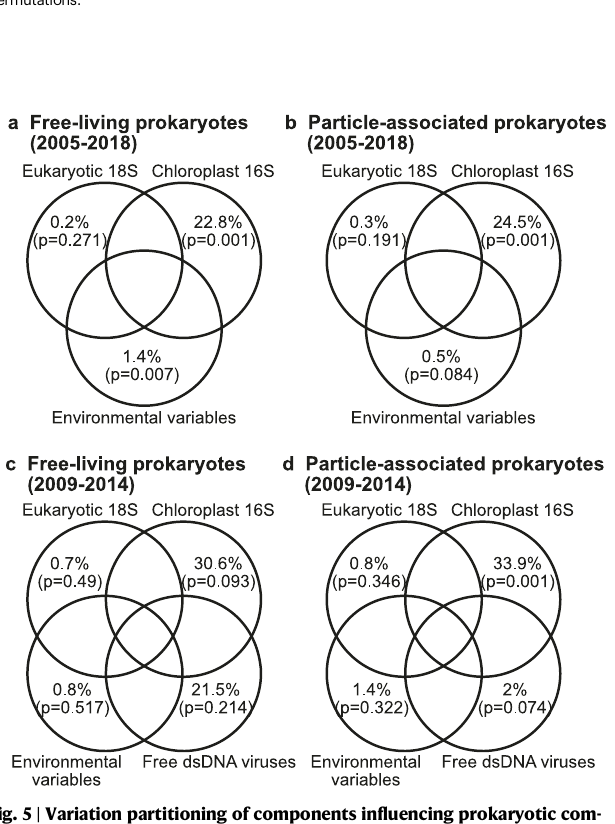
Fig. 5 | Variation partitioning of components in fl uencing prokaryotic com- munity composition. Percentages indicate the portion of the variance in free- living ( a , c ) and larger or particle-associated ( b , d ) prokaryotic community com- position statistically explained by the respective variable. Environmental variables include temperature and chlorophyll-a. Virus data (in c , d ) are available for